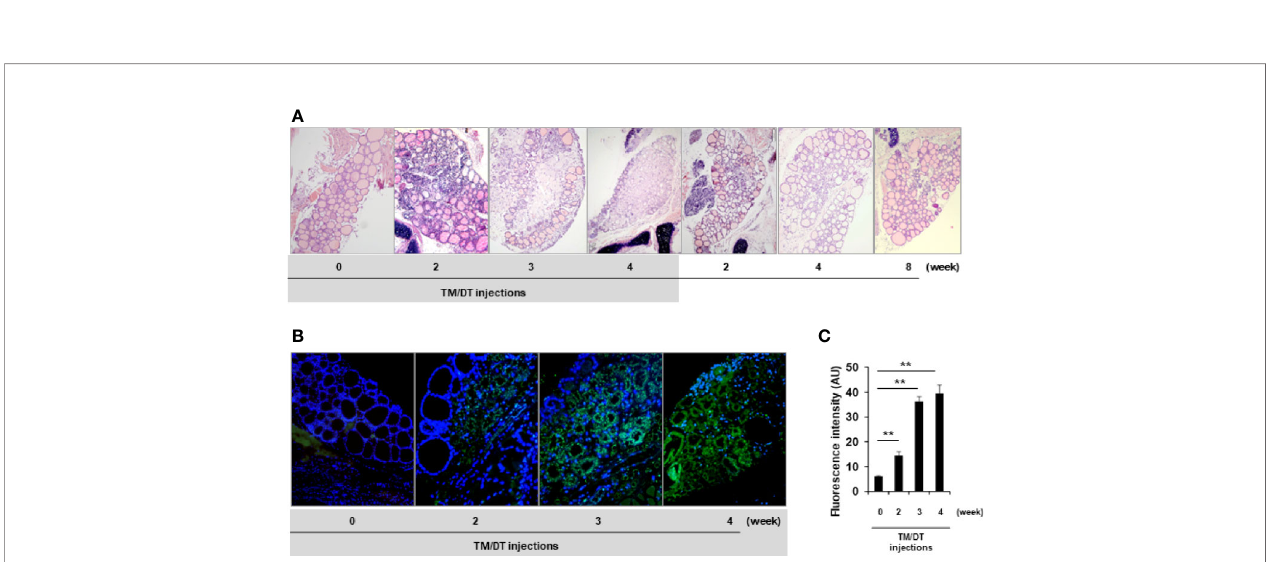
FIGURE 3 | Histologic analysis of thyroid glands from TPOCreER2/iDTR mice. (A) H&E staining: Representative images of H&E analysis from control and TPOCreER2/iDTR mice following TM/DT administration and after stopping administration at different time points as indicated. Pre-injection (0 weeks): An intact thyroid gland is shown with well organized follicles; TM/TD injection (2, 3, and 4 weeks): Increasing damage to the gland is seen with a dramatic decrease in follicles observed with the normal structure of the thyroid gland almost extinguished; After stopping TM/TD injections (+2, +4, +8 weeks): The thyroid basic unit, the follicles, were observed to be increasing in number after stopping the TM/TD injections. (B) Apoptosis Analysis: Representative images of apoptosis staining from the control and TPOCreER2/iDTR mice following TM/DT administration at different time points as indicated. Pre-injection (0): No TUNEL positive cells in the thyroid follicles. TM/ TD injection (2, 3, and 4 weeks): Abundant apoptotic TUNEL positive cells (green) observed with time. (C) Quantitative analysis of apoptosis in the thyroid: Apoptosis staining of TM/TD injected mouse thyroid as shown in B was quanti fi ed by image analysis software and expressed in arbitrary units (AU). At least three positive images were counted in each group and mean and SD were plotted. The positive staining after TM/TD injections at 2, 3, and 4 weeks were signi fi cantly higher than pre-injection (0) thyroids (p <